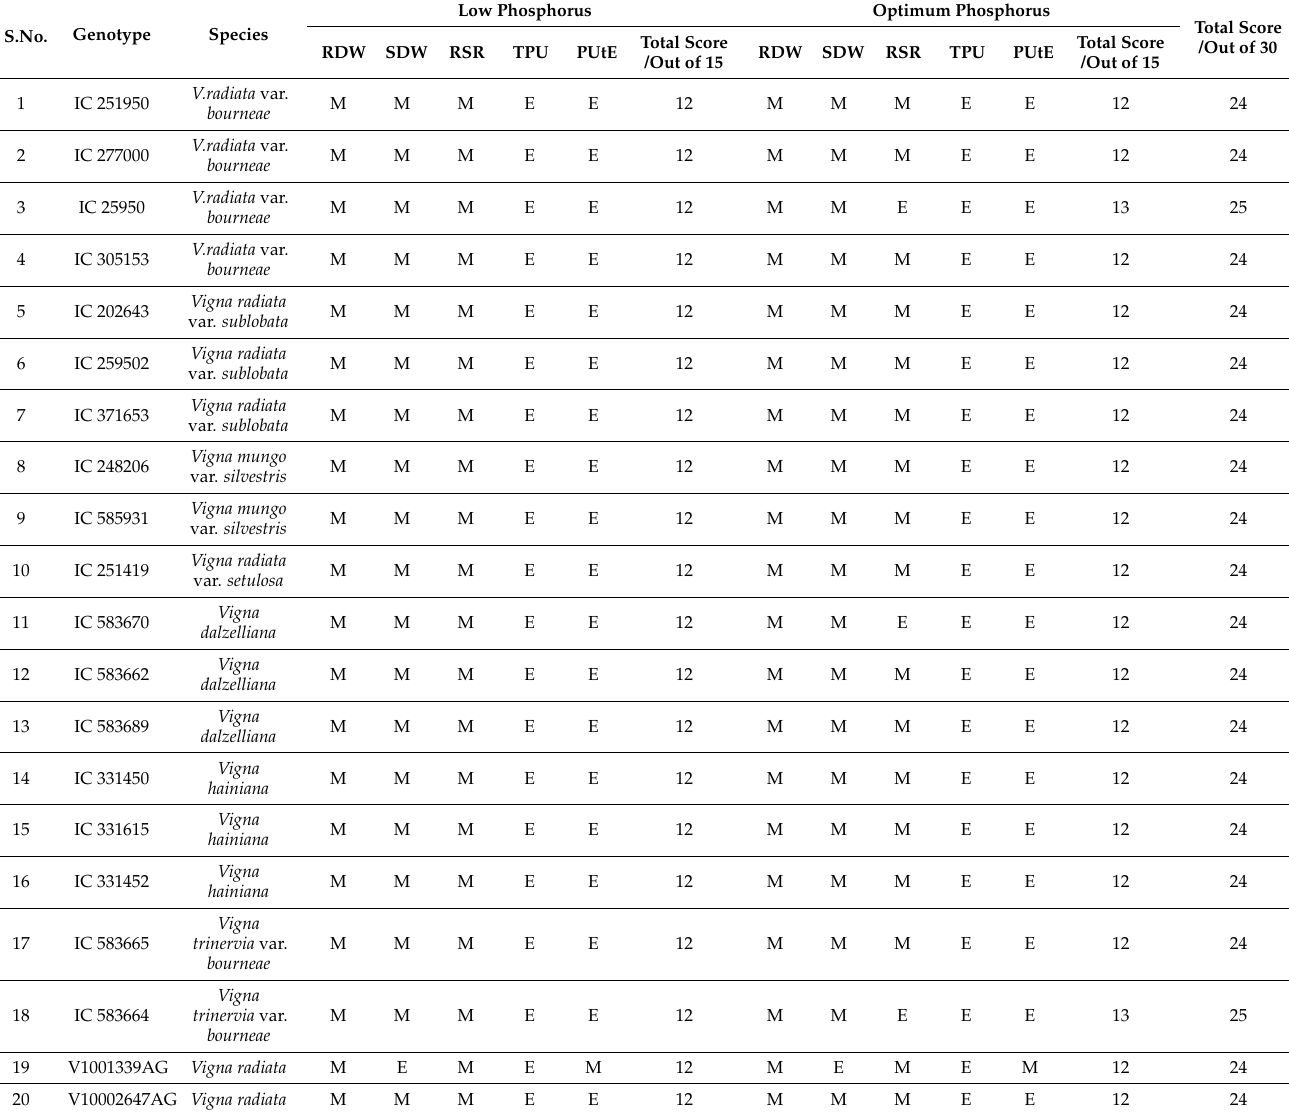
Table 5. Efficient genotypes identified based on population mean and standard deviation under low-phosphorus and optimum-phosphorus conditions